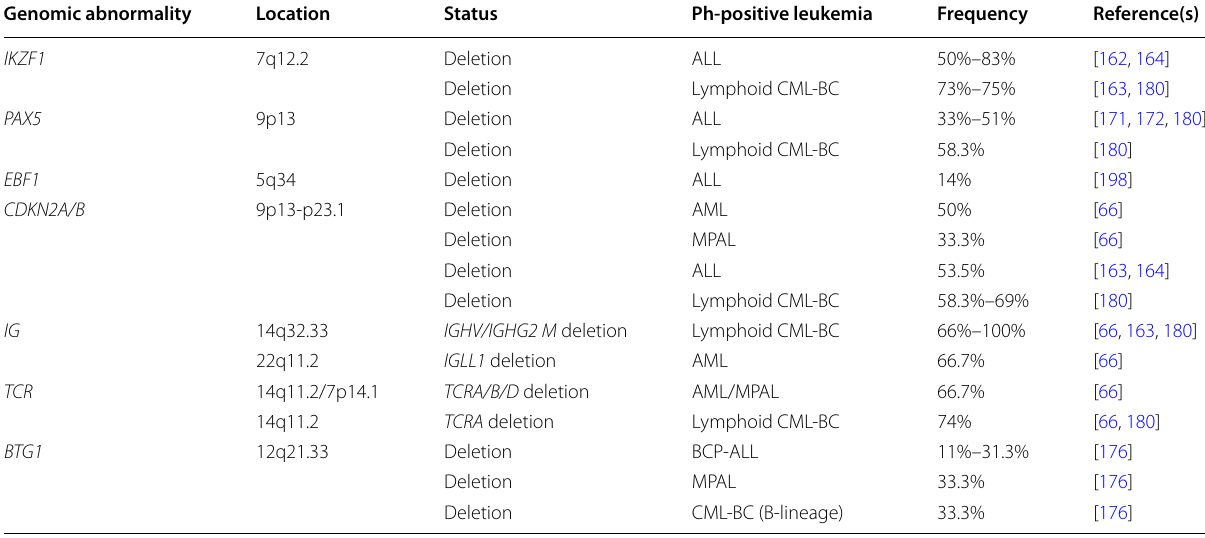
Table 1 Recurrent genomic abnormalities in Philadelphia chromosome (Ph)‑positive